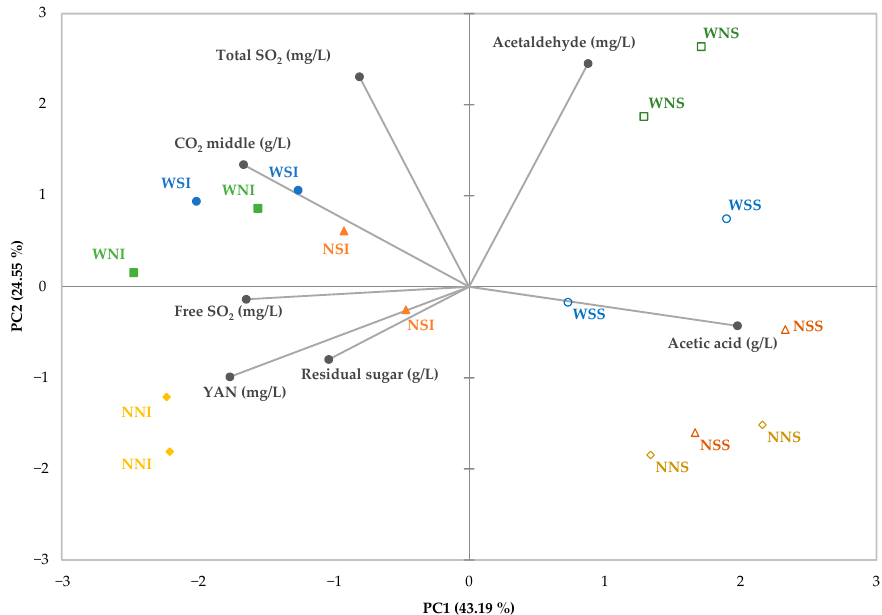
Figure 6. Bi-plot of the Principal Component Analysis (PCA) with the main enological parameters of wines obtained with spontaneous (S) and inoculated (I) microvinification trials of four grape musts. Washed grapes with SO 2 (WSS and WSI), washed grapes without SO 2 (WNS and WNI), non-washed grapes with SO 2 (NSS and NSI), non-washed grapes without SO 2 (NNS and NNI).